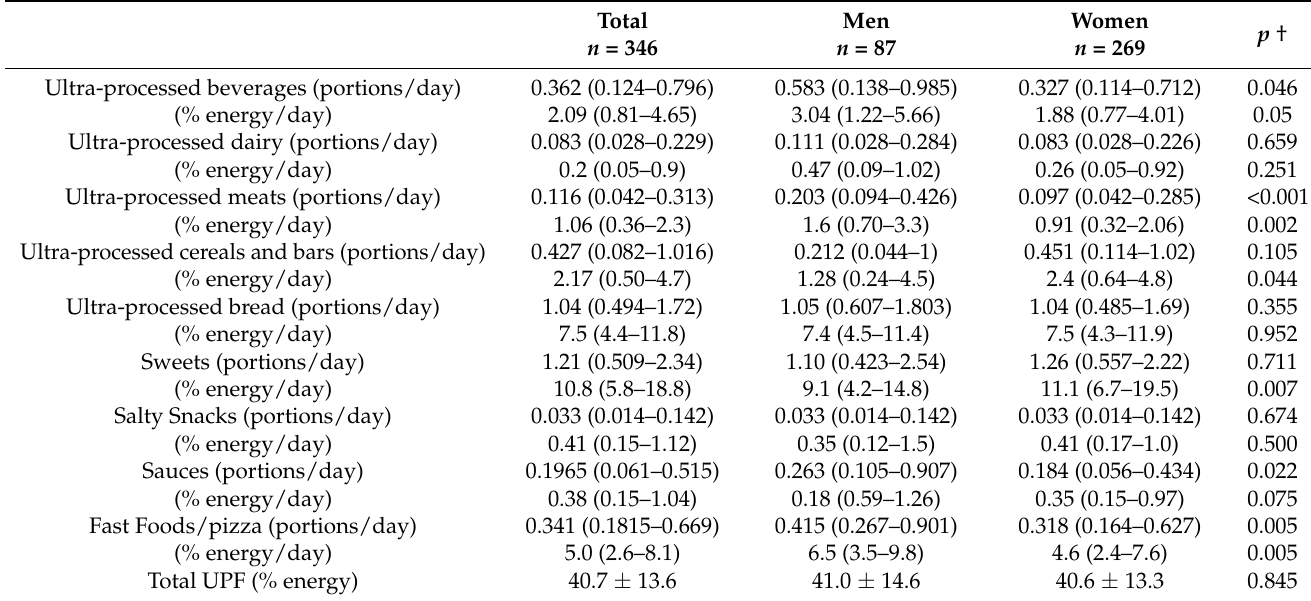
Figure 1. Daily energy intake from several categories of ultra-processed foods. Table 2. Daily intake of UPF.